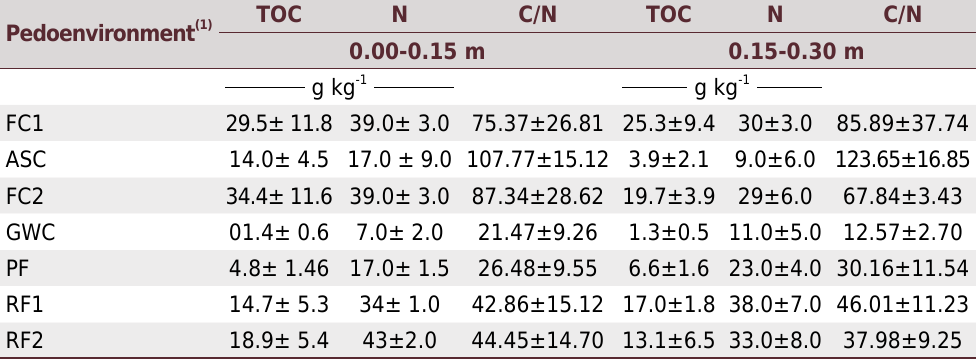
Table 2. Total organic carbon (TOC), total nitrogen, and C/N ratio in soils under different pedoenvironments at two soil depths, in the Viruá National Park, Roraima,